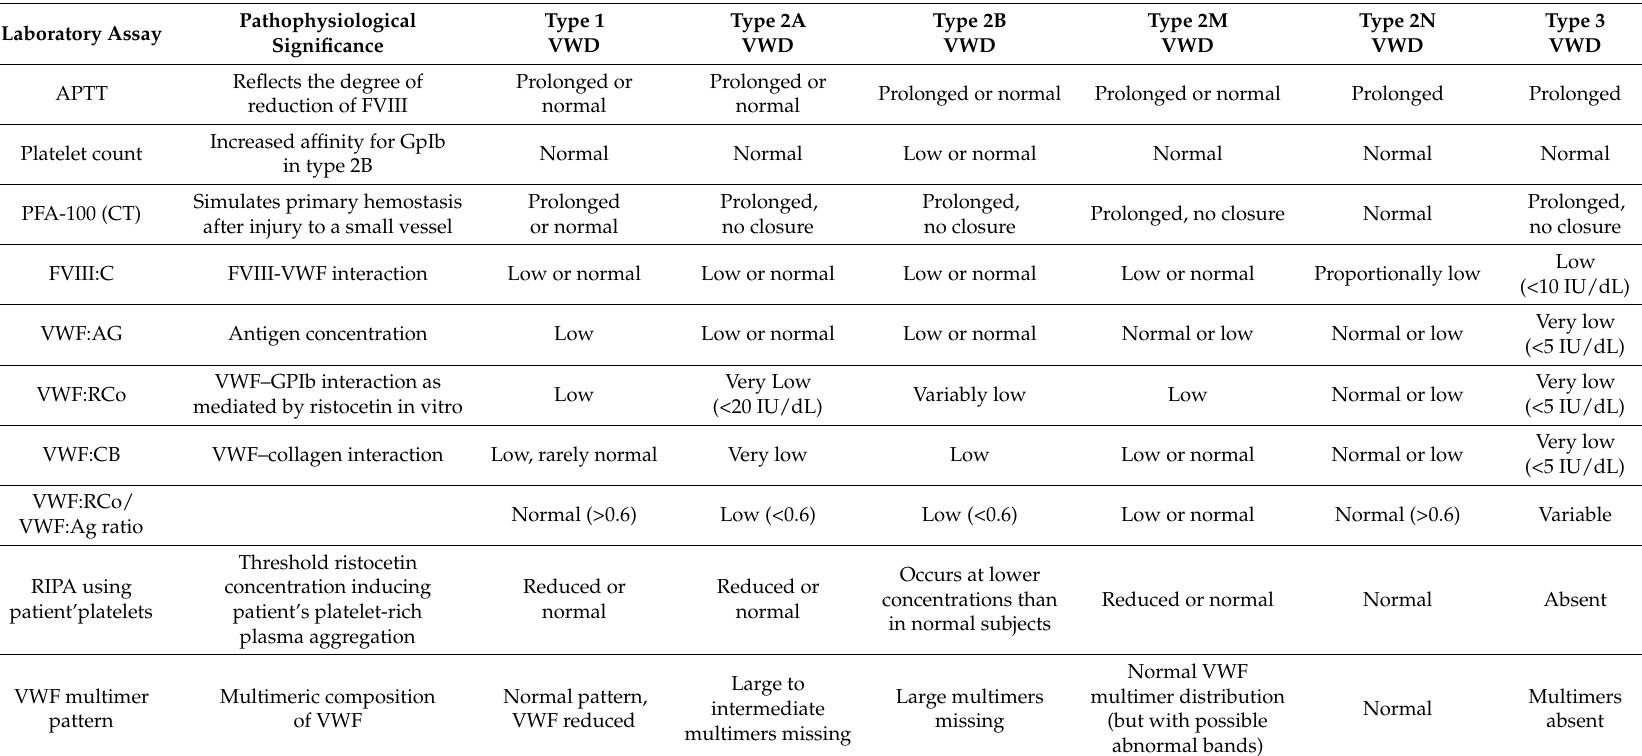
Table 2. Laboratory patterns in von Willebrand disease